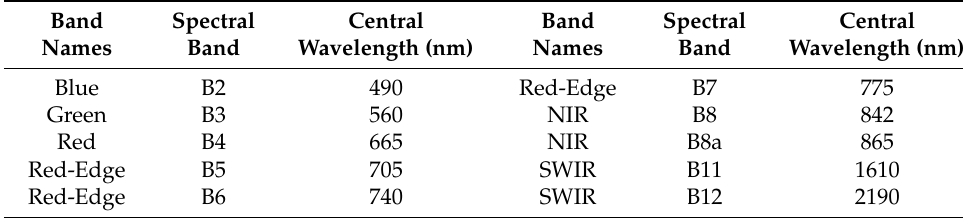
Table 1. Spectral bands of Sentinel-2 images.